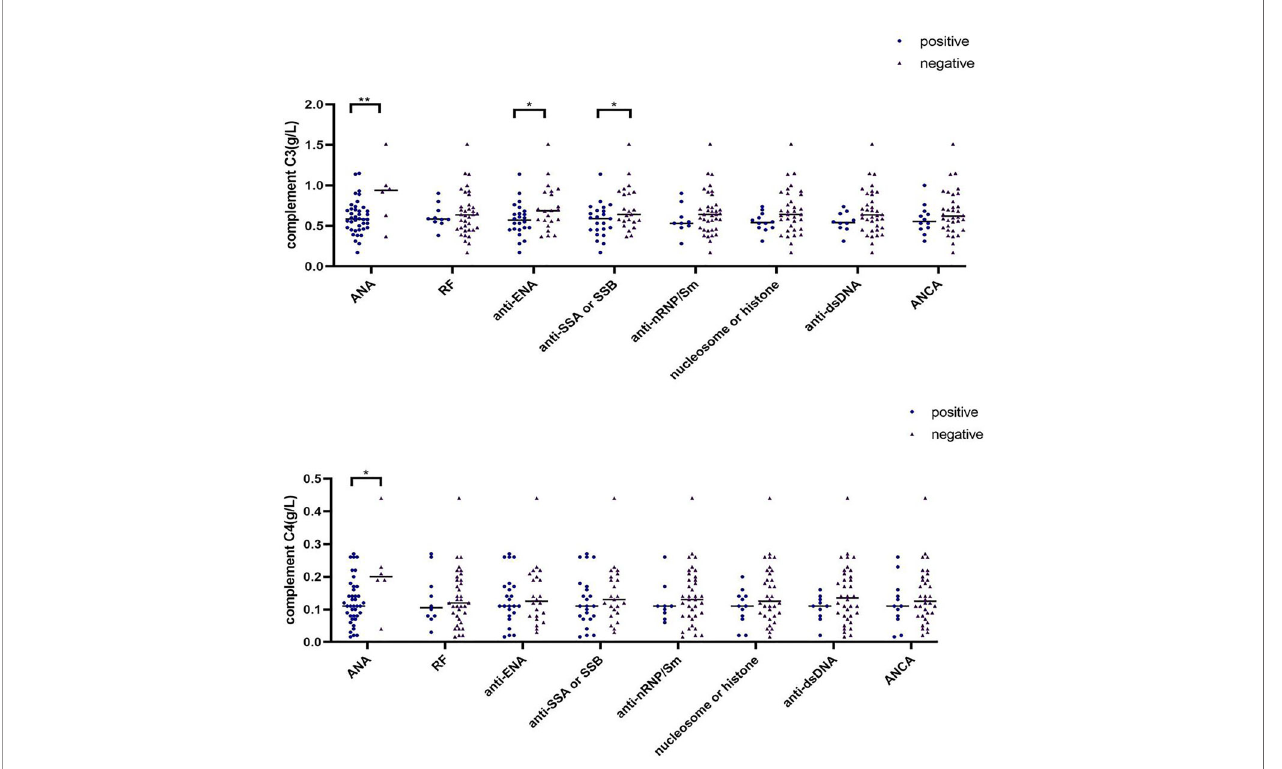
FIGURE 5 | Differences in complement C3 and C4 levels among different antibody subgroups in SAPS group ( ∗ p < 0.05, ∗∗ p <